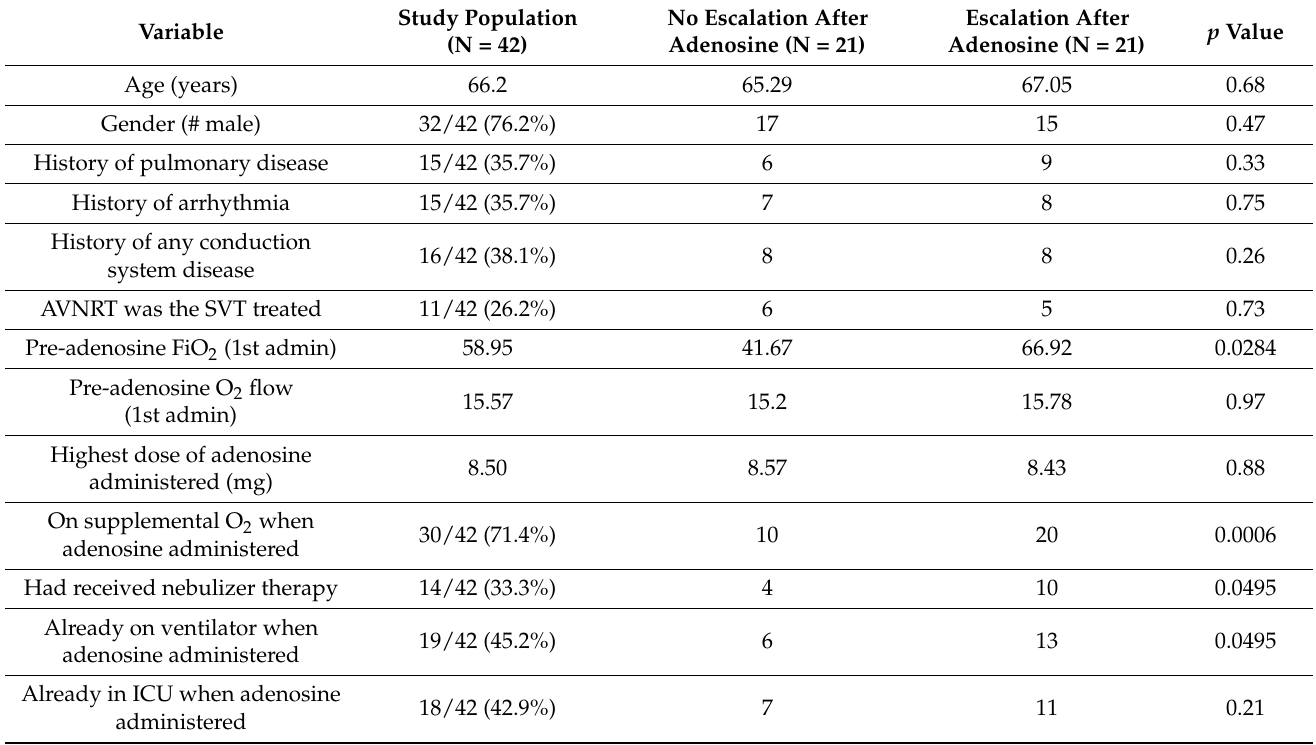
Table 3. Control group. Clinical variables are shown for all control group patients, and also separately for patients who did not and did require escalation of care.